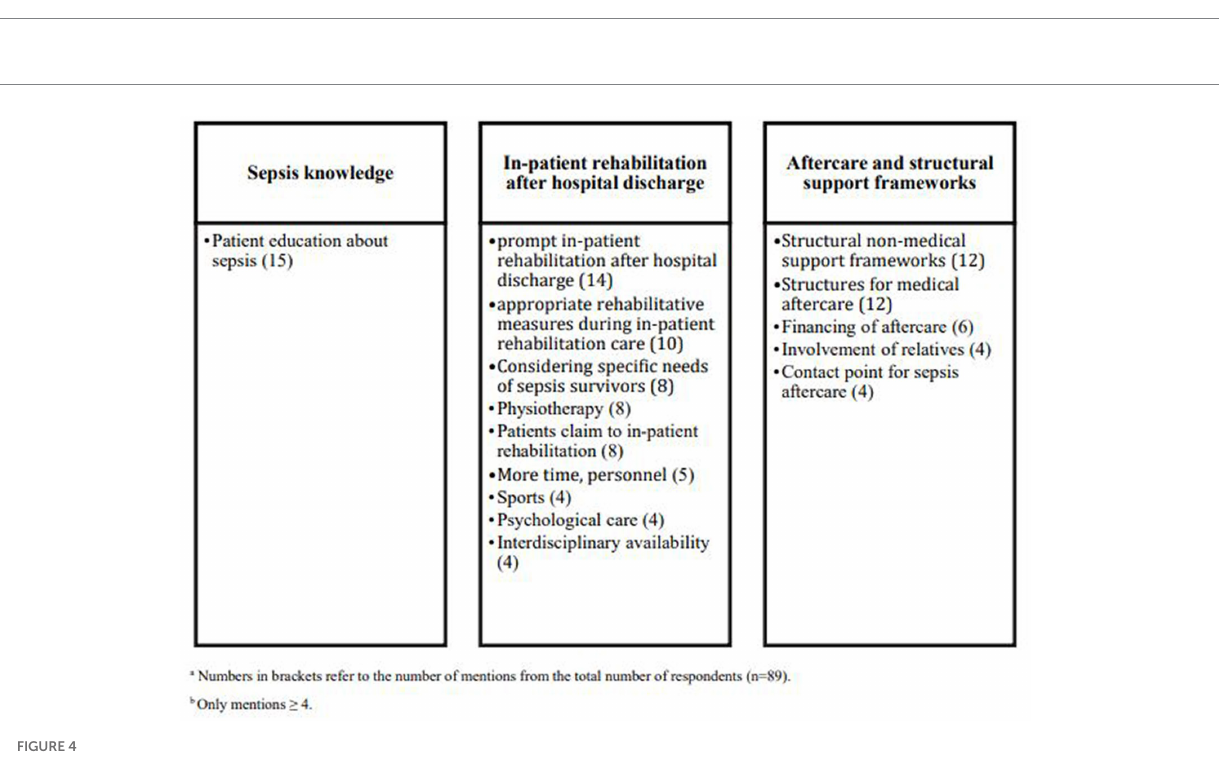
FIGURE 3 Rating of satisfaction with fit, extent and outcome of (A) rehabilitation by impairment and (B) rehabilitation and aftercare in general (combined for 6 and 12 months